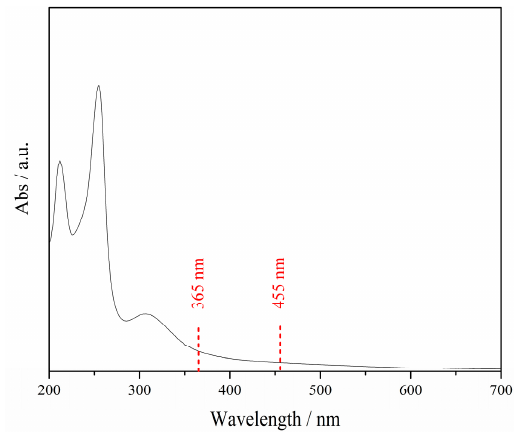
Figure 2. Absorption spectrum of a 100 µM chlorpromazine solution in water.